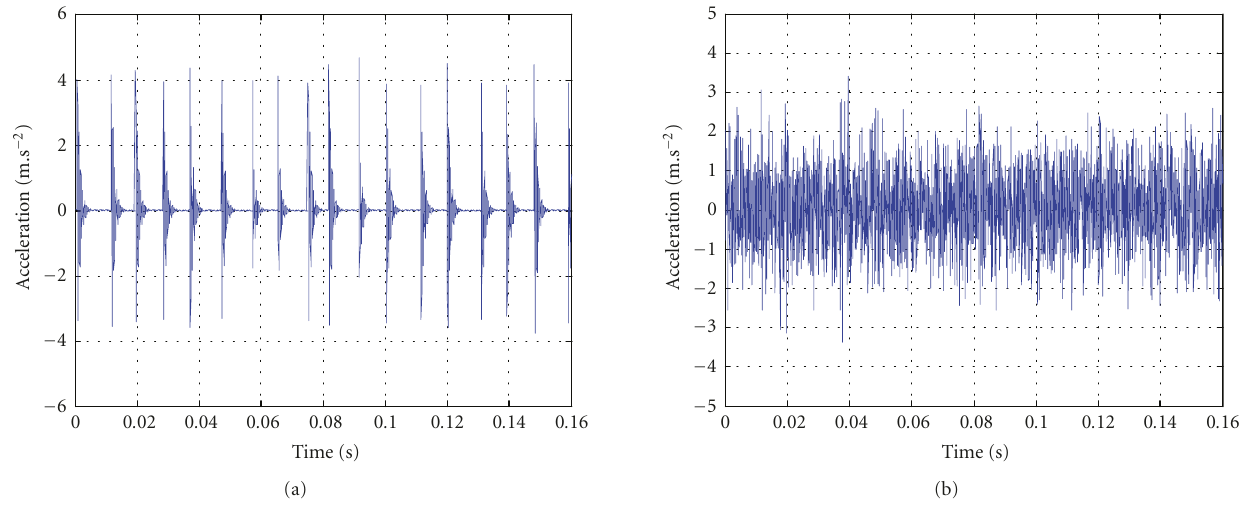
Figure 1: The simulated impulses (a) and the vibration signal (b) for a rolling bearing with outer-race fault.